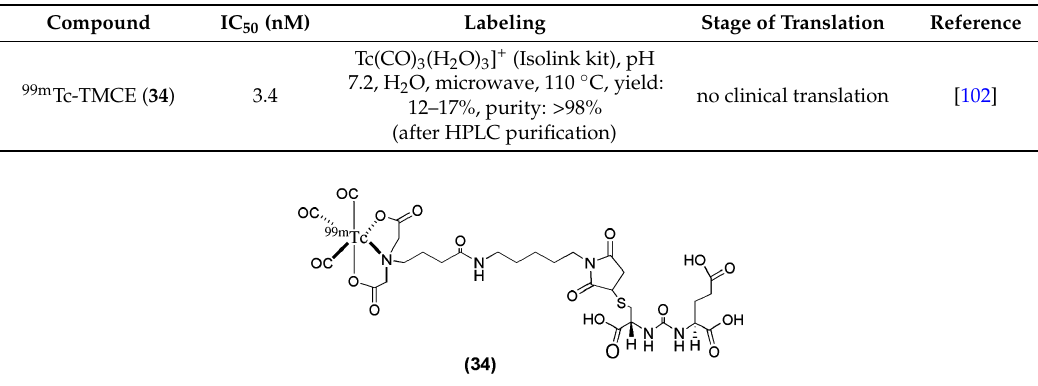
Figure 9. Chemical structure of 99m Tc-TMCE ( 34 ) [102].